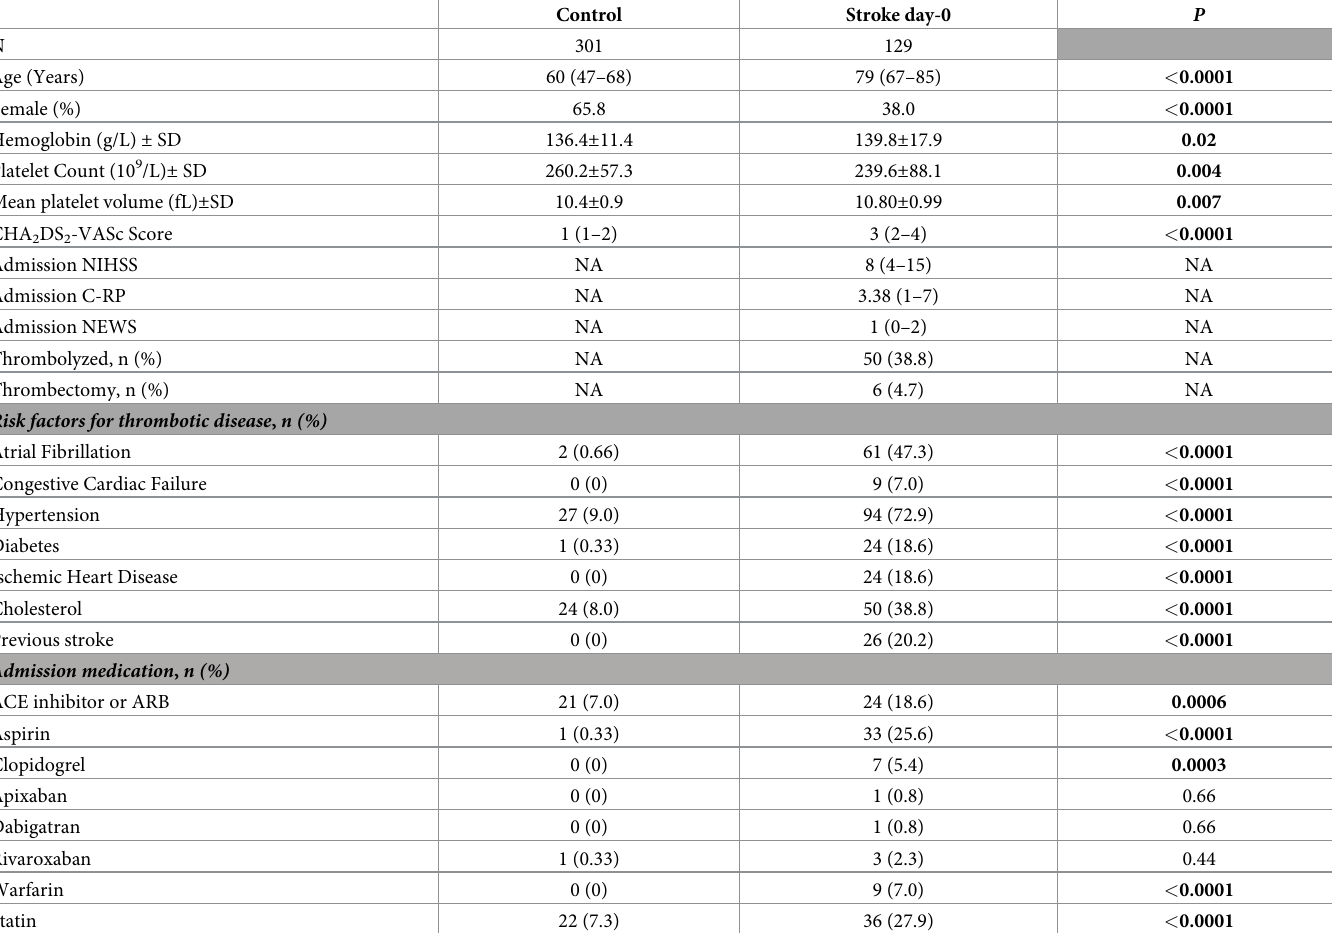
Table 1. Baseline characteristics of control and stroke groups at admission, including haematological parameters, vascular risk factors and admission details.